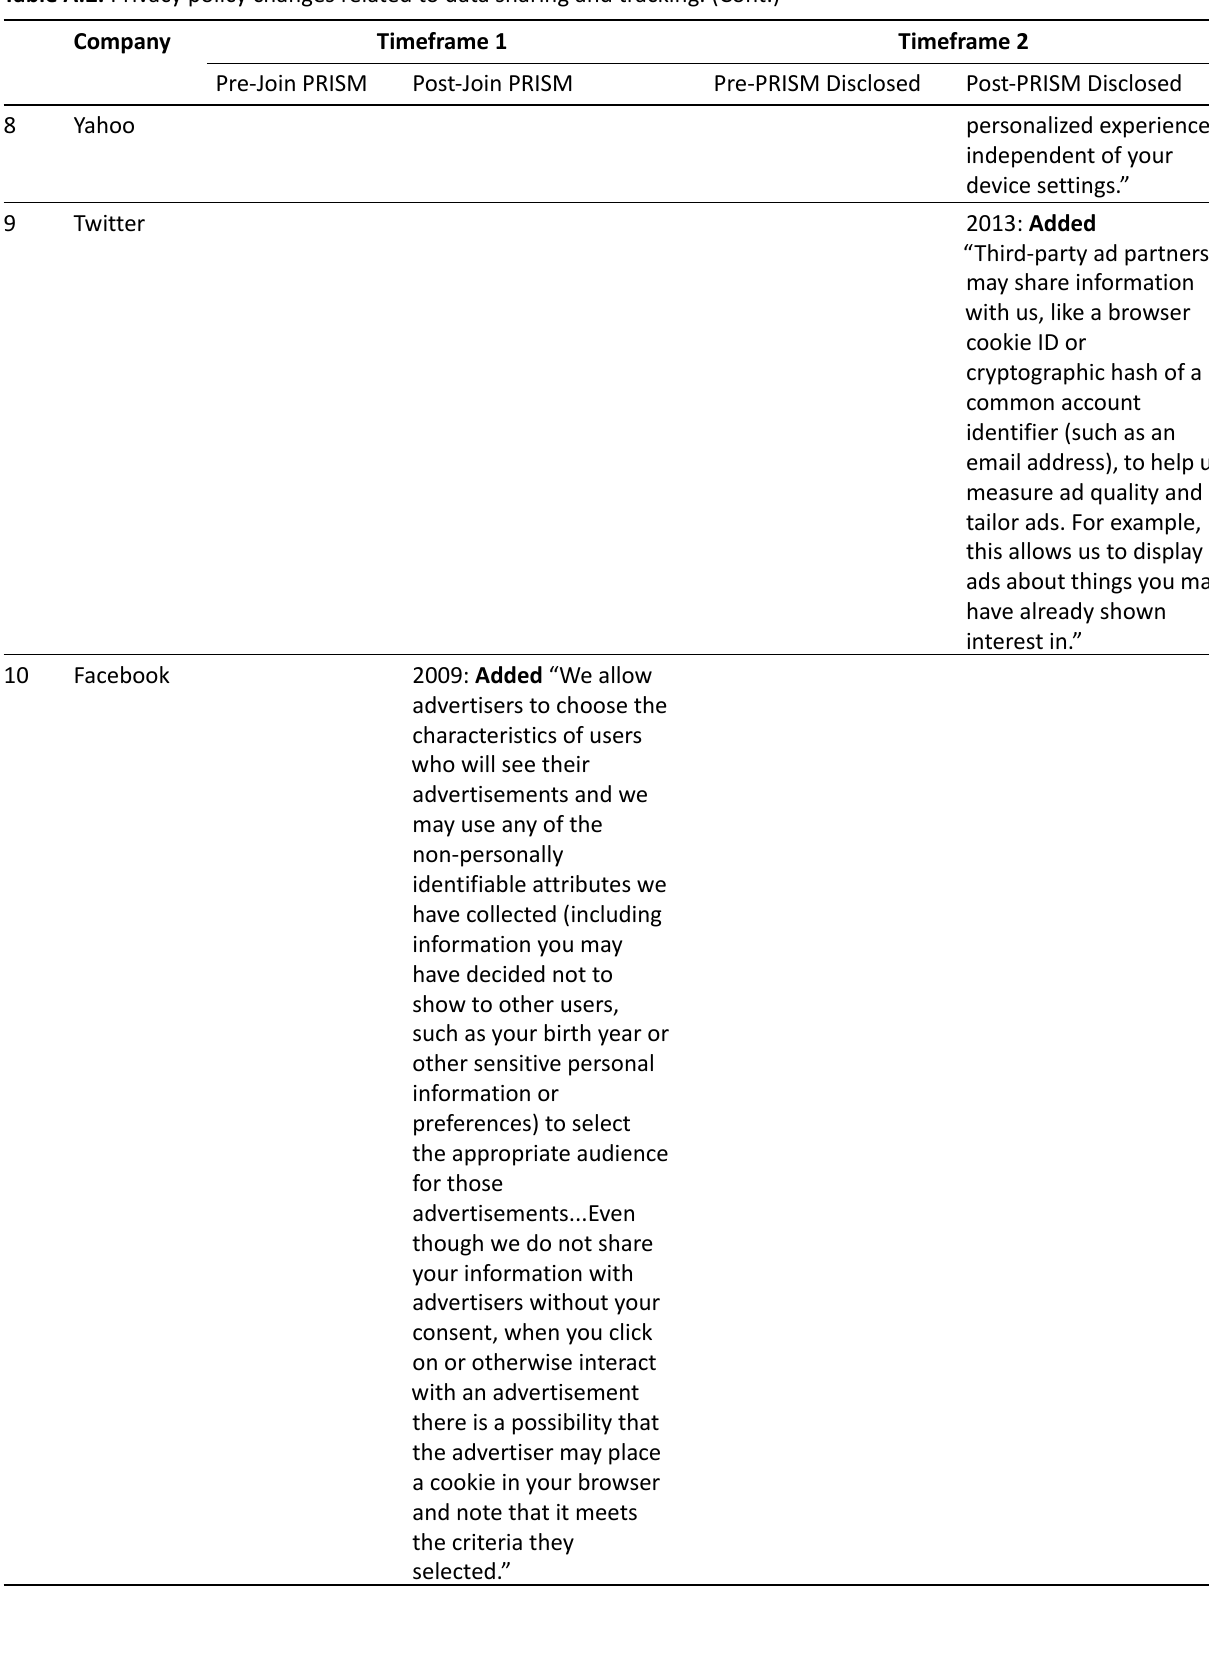
Table A.2. Privacy policy changes related to data sharing and tracking.